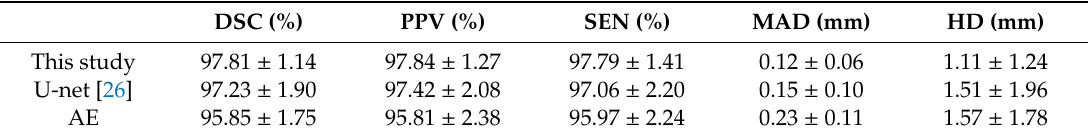
Table 2. Quantitative comparison of the segmented results of the proposed system, U-net, and AE in terms of DSC, positive predictive value (PPV), sensitivity (SEN), mean absolute distance (MAD), and Hausdor ff distance (HD). (mean ± standard deviation). The AE system was built by removing the skip connections of the